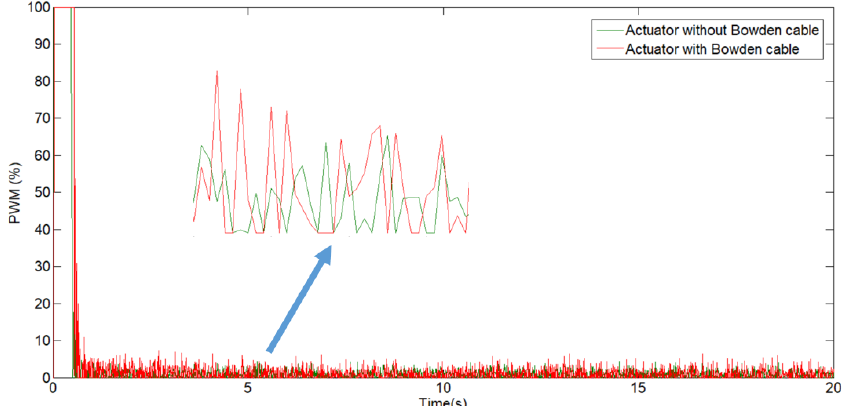
Figure 9. Actuator PWM signals with Bowden and without Bowden